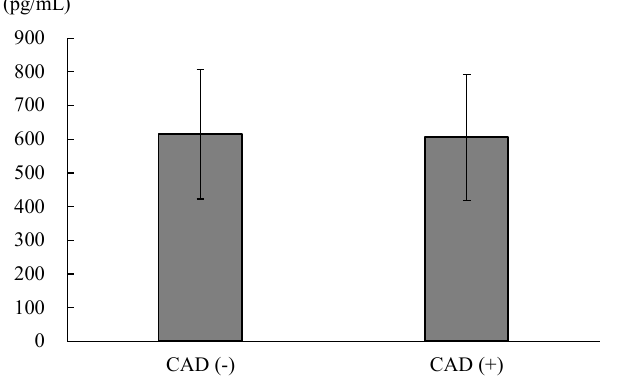
Figure 1. The comparison of the plasma concentrations of dickkopf-1 between patients without coronary artery disease (CAD) and those with CAD (614 ± 192 vs. 606 ± 187, p = 0.622).